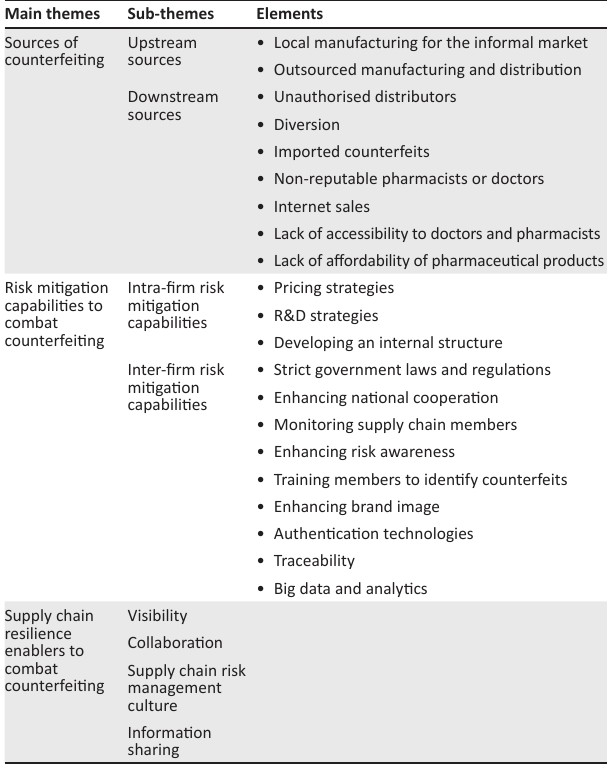
TABLE 2: A summary of the research